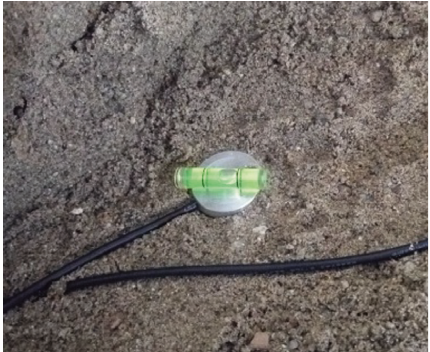
Figure 5: Soil pressure sensor.